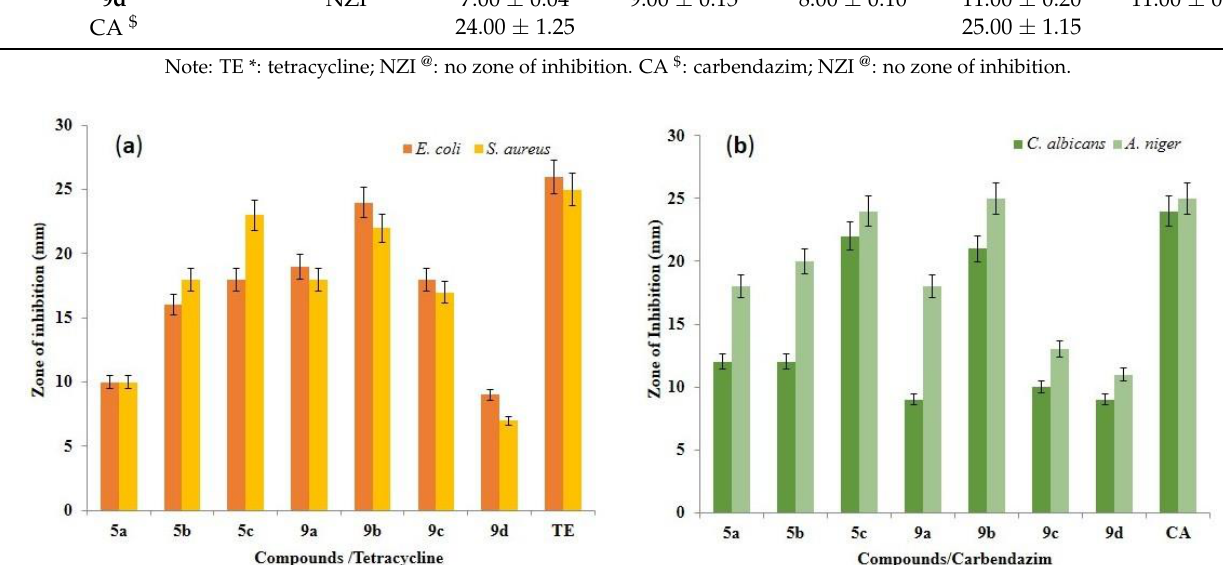
Figure 7. Antimicrobial activity of compound 9b against common bacterial pathogens. a: 50 µL, b: 75 µL, c: 100 µL, d: positive control, e: negative control. 4. Conclusions The synthesis of new multiblock chalcone conjugate phthalimide and naphthalimide functionalized copolymers with a topologically novel architecture synthesis using nu- cleophilic substitution and polycondensation methodology have been successfully ex- plored. We have synthesized phthalimide- and naphthalimide-containing novolac ana- logs conjugated with a chalcone spacer via sequential nucleophilic substitution and condensation reaction in a triethylamine base. Spectroscopic analysis including FTIR, 1H NMR, and 13C NMR spectroscopy confirms the structures of the synthesized novolacs. The synthesized multi − block novolacs are photoactive; notably, 1,8-naphthalimide pen- dant organic functional group novolacs showed interesting optical activity compared to the other phthalimide pendent functionalized novolacs. All the 1,8-naphthalimide de- rivatives showed UV absorption and emission. Employing